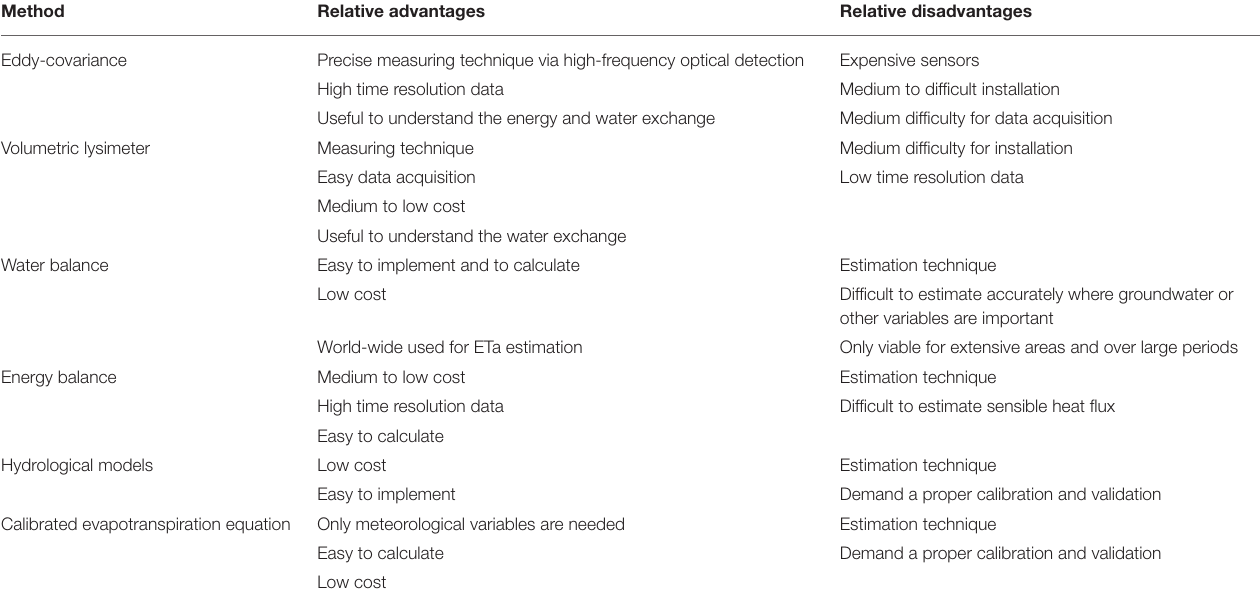
TABLE 5 | General advantages and disadvantages of the actual evapotranspiration measurement and estimation